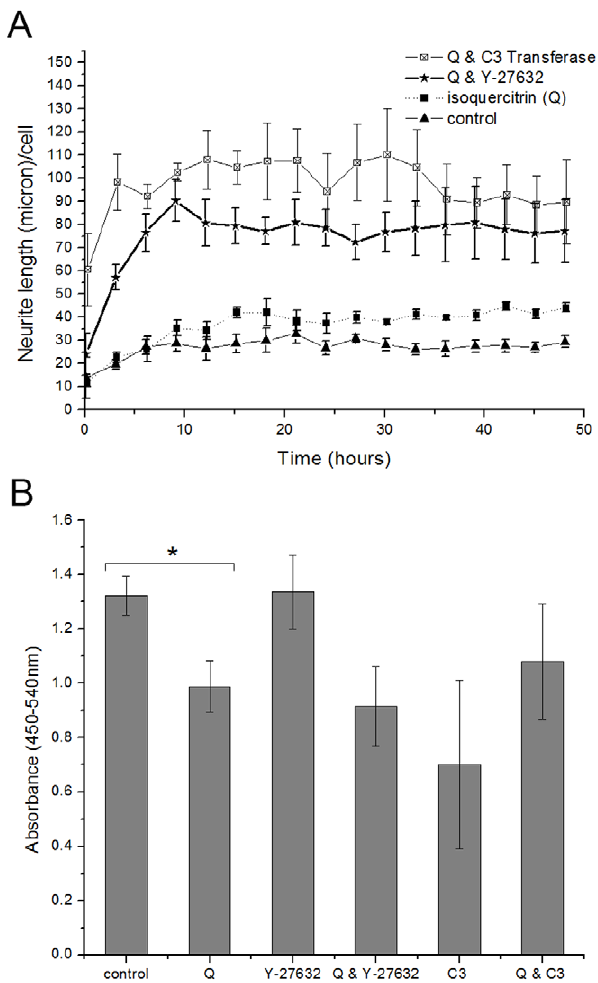
Figure 3. Analysis of neurite length/cell vs. time. A, Quantifica- tion of neurite length/cell upon addition of isoquercitrin alone or in combination with Rho inhibitors over a period of 48 hours (n=3, one way ANOVA for repeated measures, F 3,8 =17.363, P=0.001). Acquisition started 30 9 after the addition of the molecules. The maximum time for one imaging cycle was 12 9 . Post hoc Bonferroni test revealed significant differences between the control and the treatments of isoquercitrin combined with each Rho inhibitor, for alpha=0.05. B, Decrease in cell proliferation, due to the presence of isoquercitrin (n=3, pair-sample t- Test, *p , 0.05). Data are shown as means 6 s.e.m.